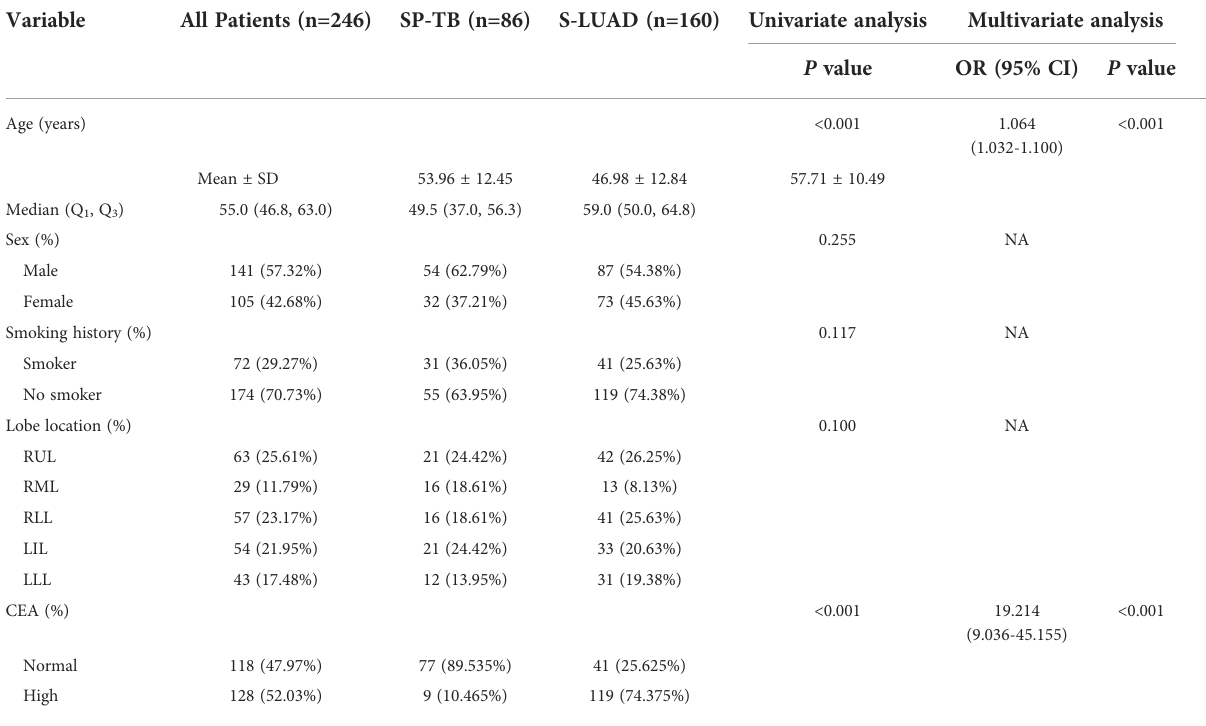
TABLE 1 Clinical characteristics of patients with SP-TB and S-LUAD.